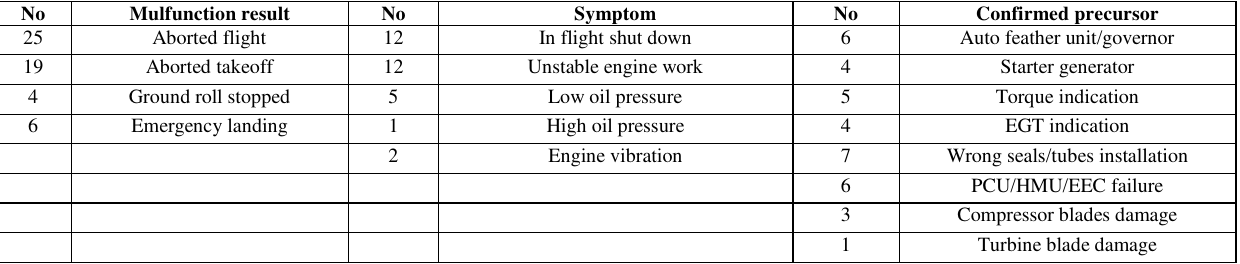
Table 11. Confirmed roots of the turboprop engines failures which caused aviation